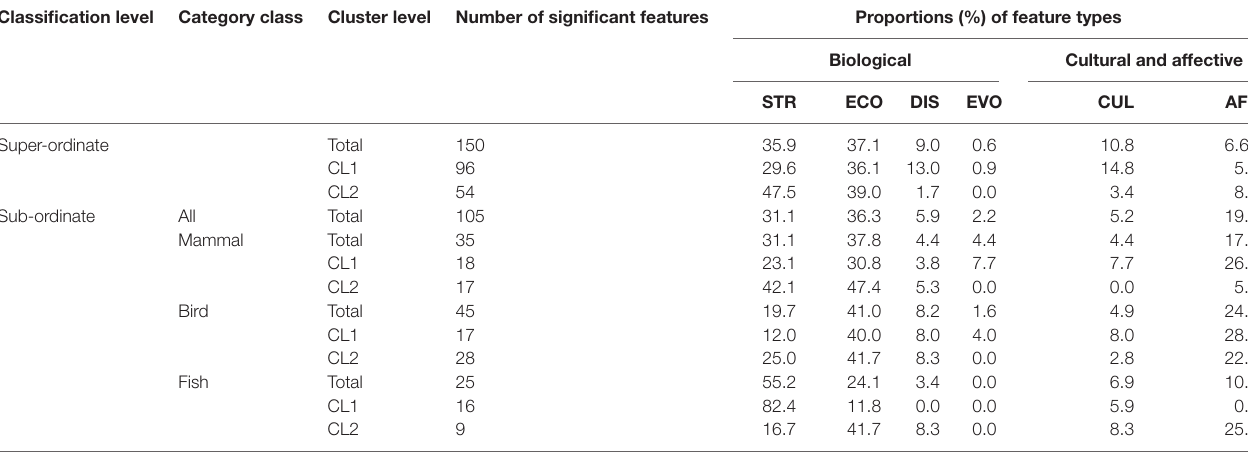
TaBle 2 | Number of significant features and ratios of the six feature types for super-ordinate and sub-ordinate category classes. classification level category class cluster level number of significant features